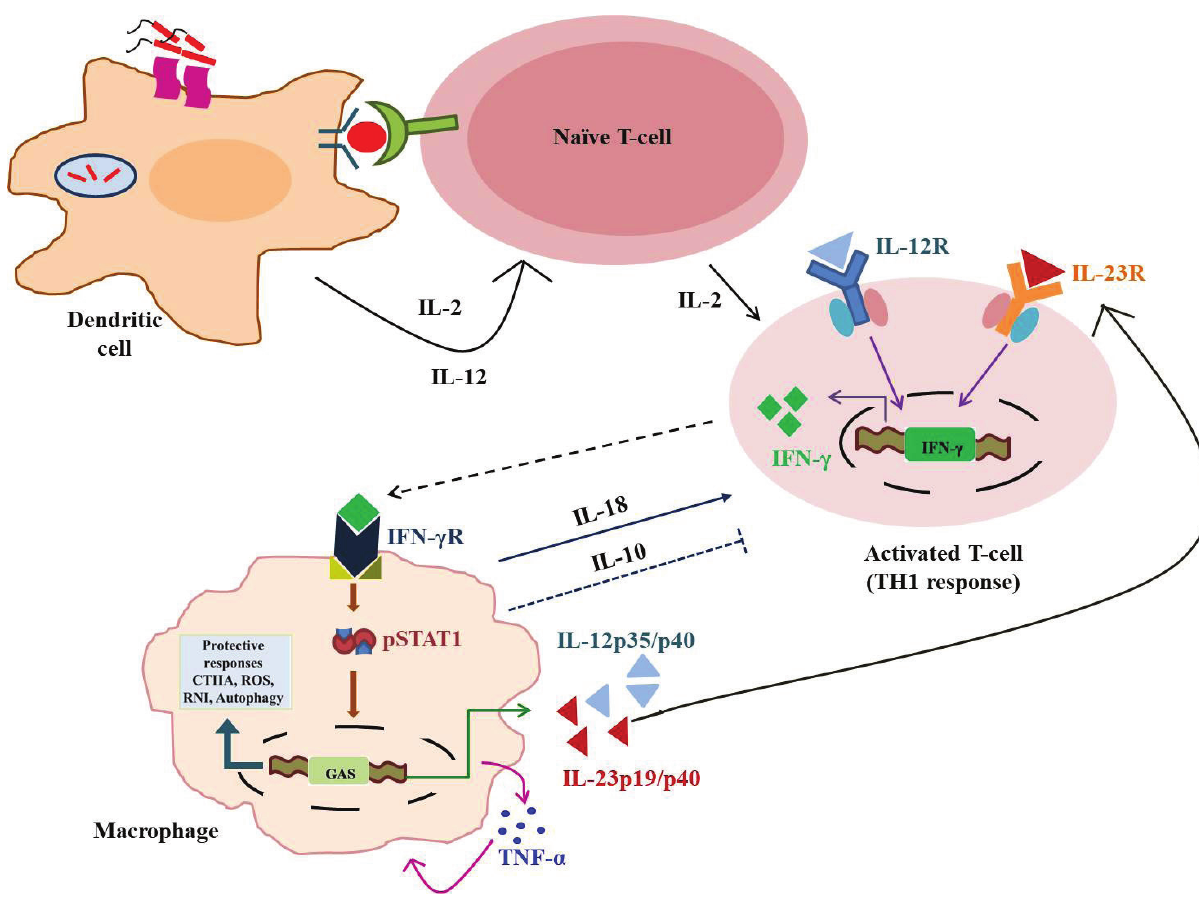
Figure 1: IFN-γ: Production and regulation. A complex interplay between various cytokines determine the transcription and production of IFN-γ. Release of IFN-γ either by NK cells or T cells triggers a series of anti-microbial responses. Following pathogenic recognition and uptake by an APC such as DC, the antigenic peptides are presented to the naïve T-cell population for initiation of an adaptive immune response. The cytokine milieu comprised of IL-12 and IL-2 triggers T cell proliferation to create conditions conducive for a pro-inflammatory phenotype. Exposure to IL-12 aids naïve cells to polarize to a TH1 phenotype. IFN-γ is a predominant cytokine in the TH1 response.